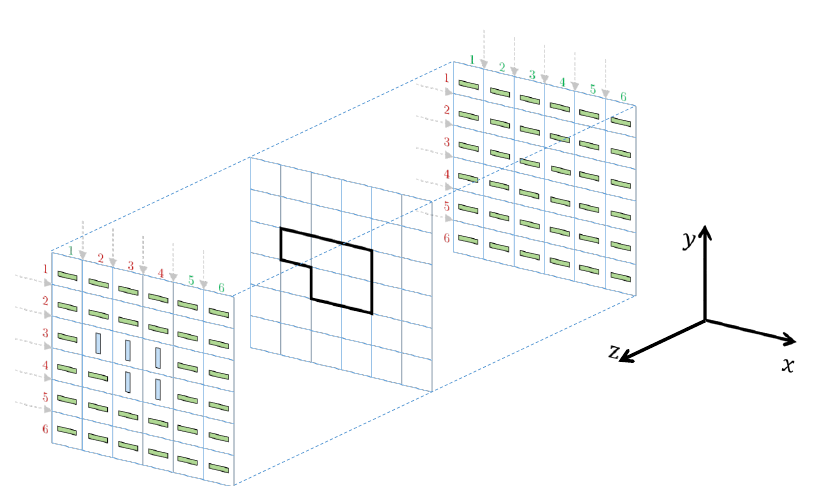
Figure 14: To create a defect loop, a layer with x blocks only is stacked on top a similar layer that also features an enclosed region of y blocks. Separately, each of these layers is compatible. However, when stacked, a defect loop matching the contour of the y blocks is formed between them. This is because along this contour each x edge ( y edge) receives 3 (1) red line contributions. Without compromising the shape and position of the defect loop, all the columns outside the cross section of the loop can be swapped in the front layer, as well as all the columns in the back